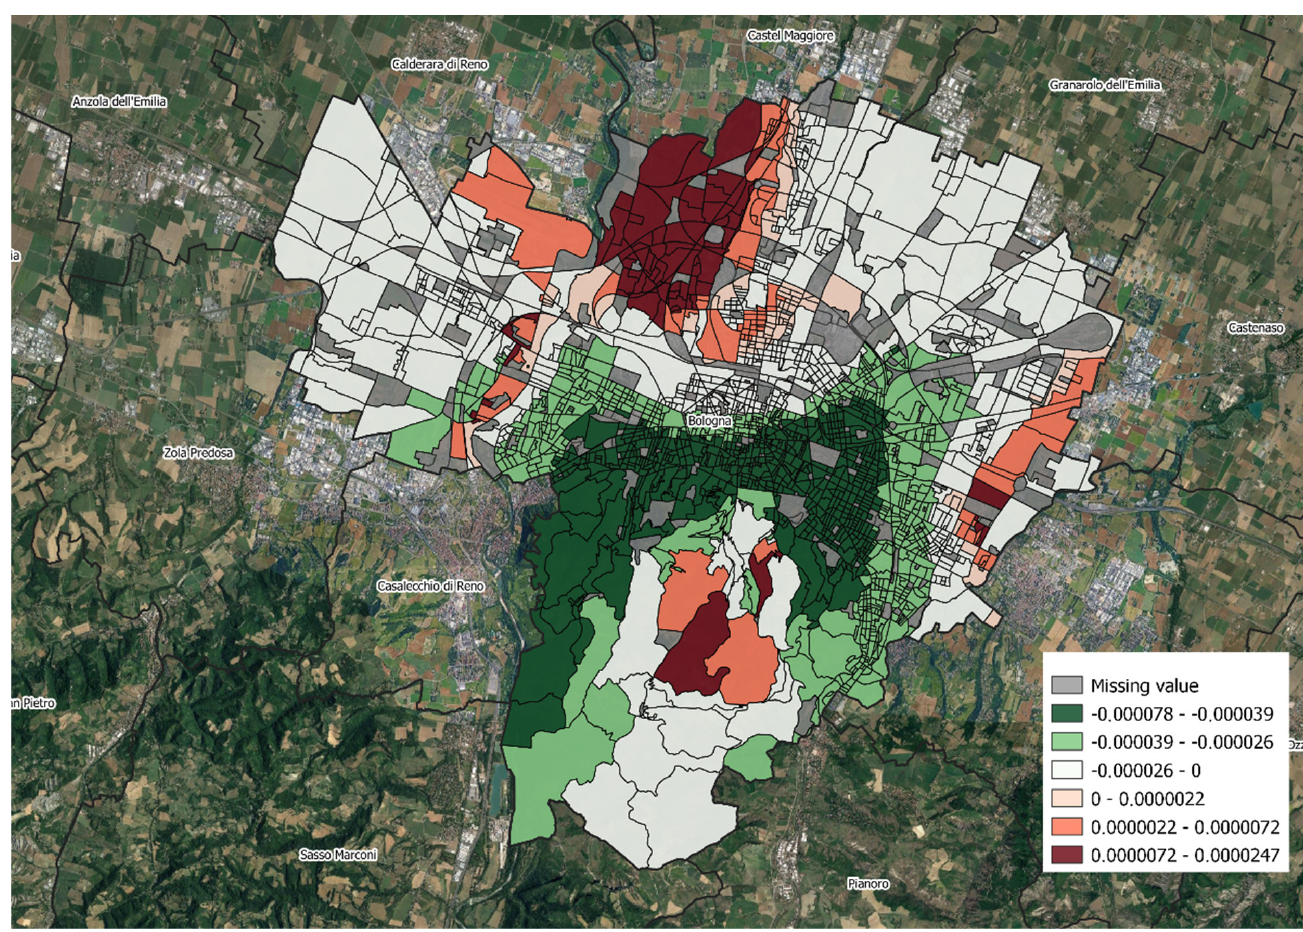
Figure 4. Map of the distribution of the local parameter estimates of GWR: coefficients for median income, Bologna.